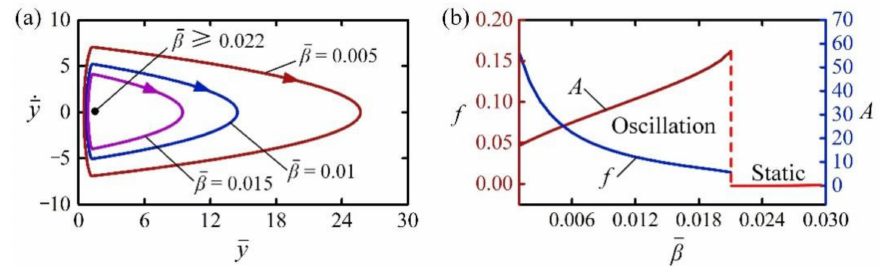
Figure 9. The effect of damping coefficient on the self-jumping for I 0 = 2, C 0 = 0.3, H = 4, g = 1, . = 0.5, E = 500, y = 30, and = 0. ( a ) Limit cycles. ( b ) Frequency and amplitude. n g = 200, p y am 0 0 As the damping coefficient increases, the frequency increases while the amplitude